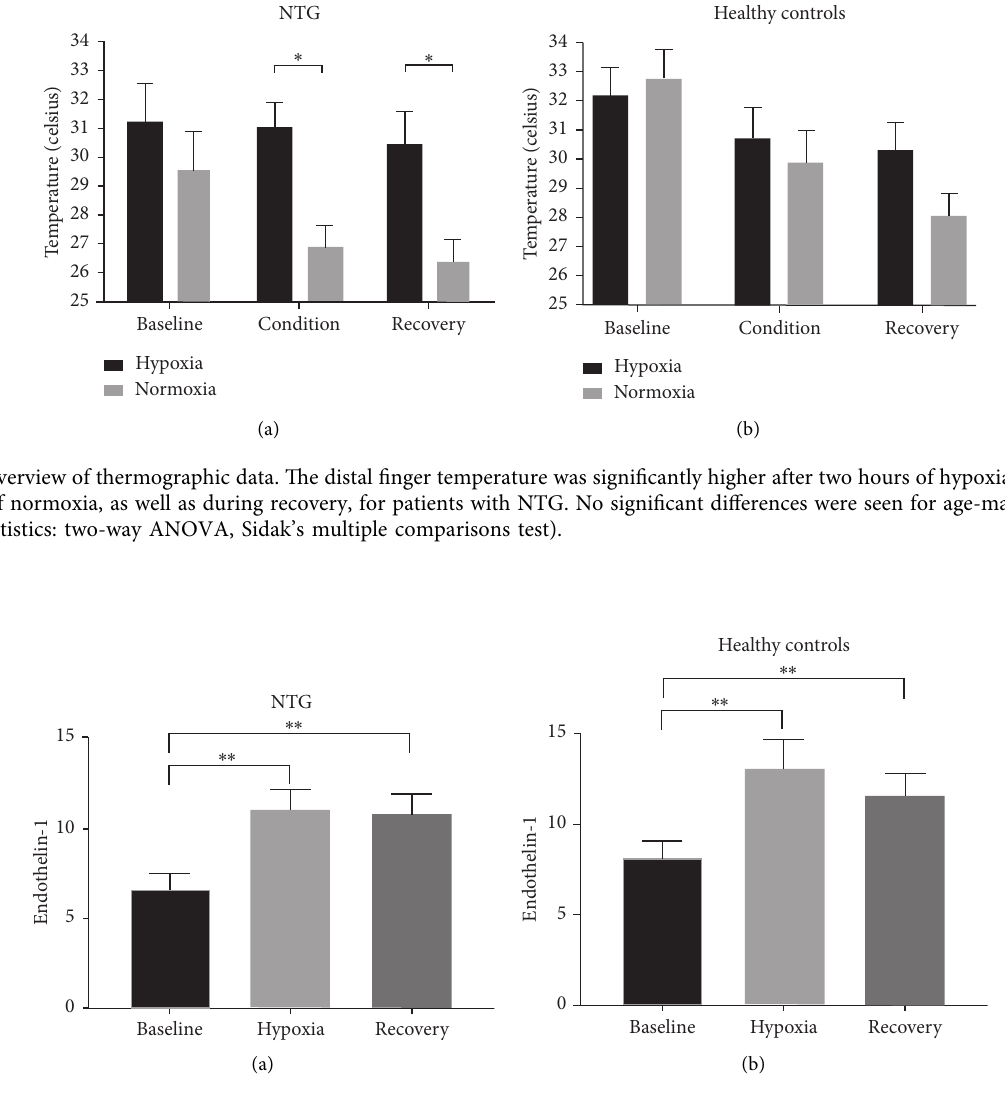
Figure 6: Overview of changes in serum levels of ET-1. ET-1 increased significantly during hypoxia in patients with NTG and in age- matched healthy controls. ET-1 levels remained high during recovery, creating a significant difference between baseline ET-1 levels and recovery in both groups (statistics: RM one-way ANOVA with Tukey’s multiple comparisons